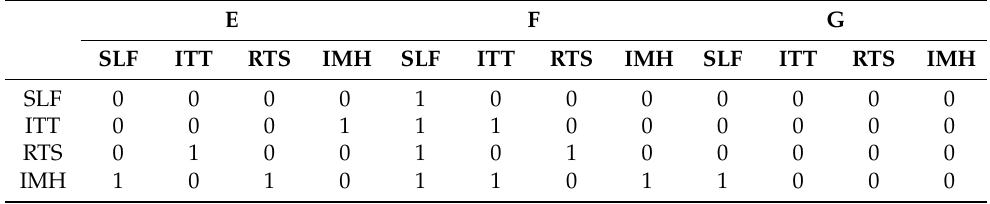
Table A19. E, F and G